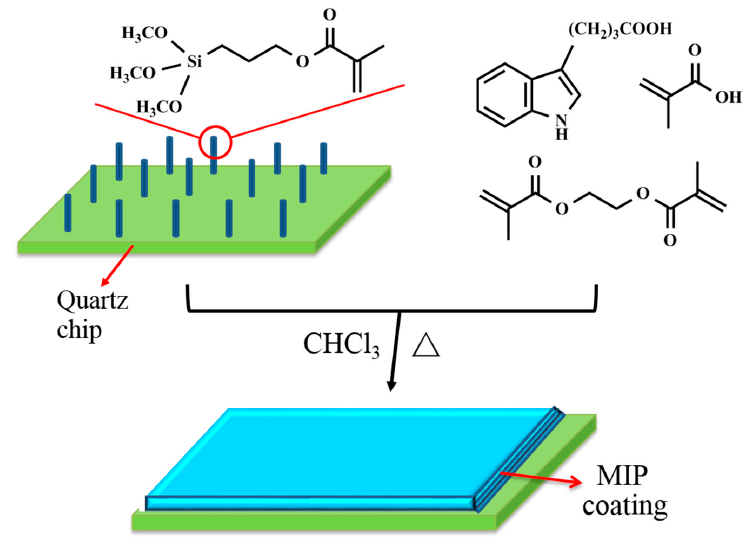
Figure 1. Schematic representation of MIP coating preparation.